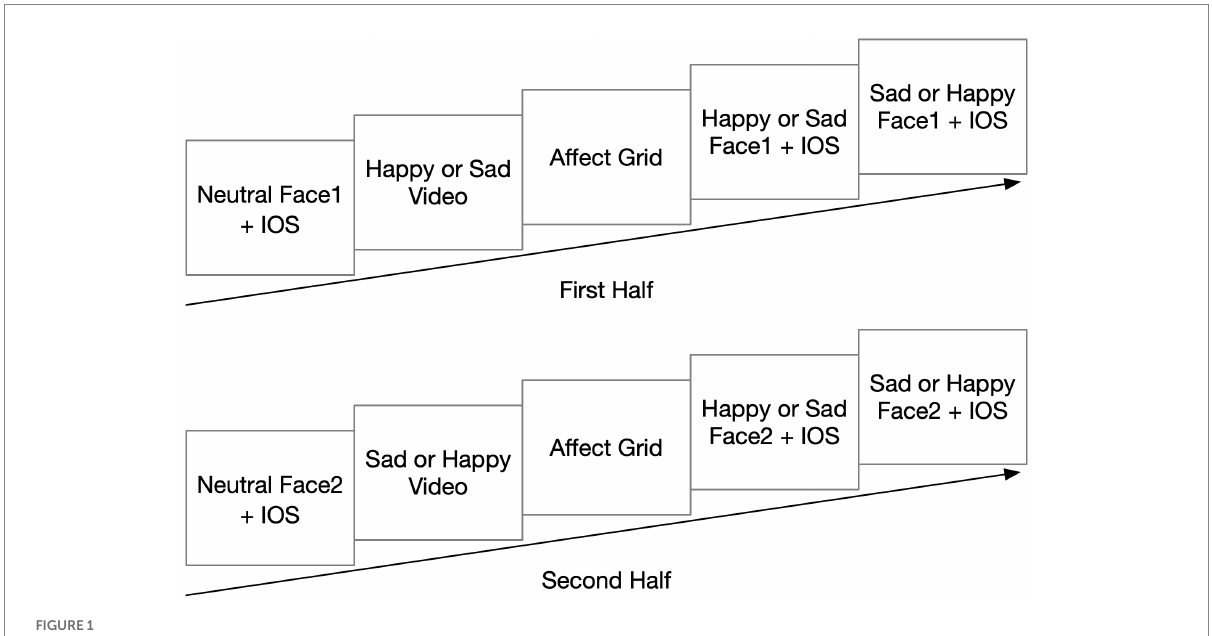
FIGURE 1 The experimental